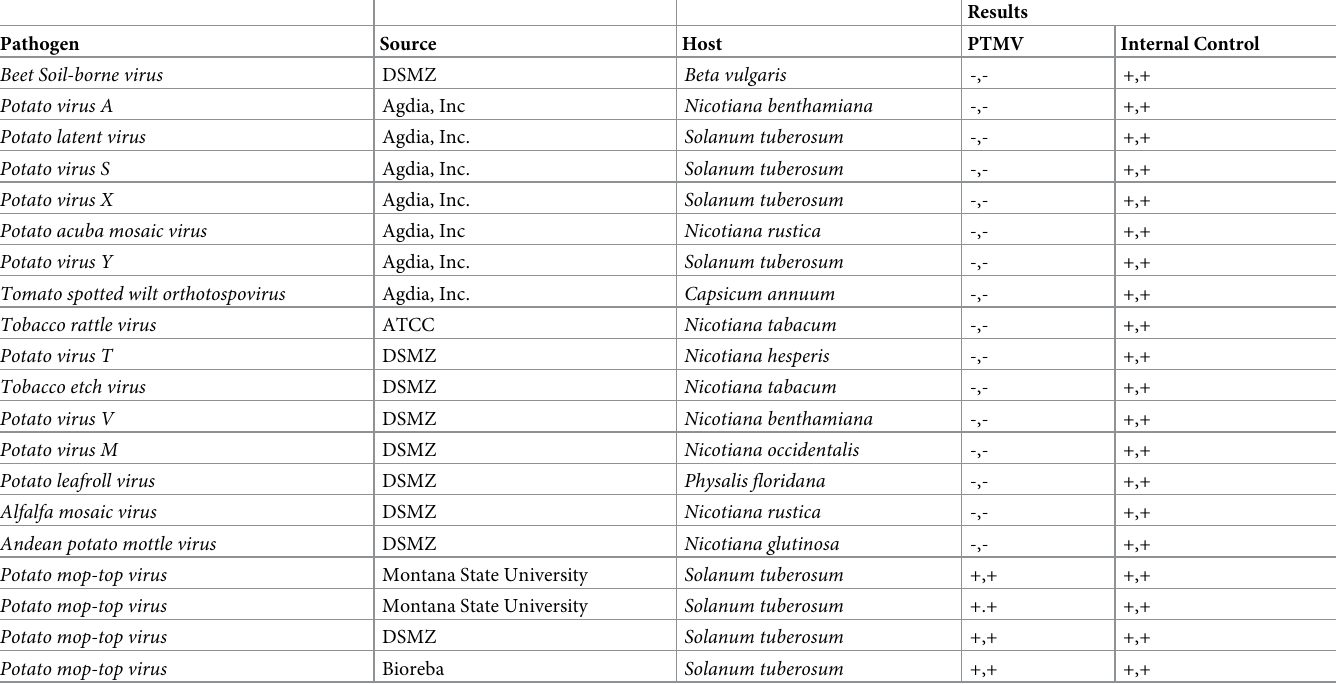
preparations of the RNA transcript defining the limit of detection (LOQ). The LOQ of our RPA assay was comparable to that of RT-qPCR and lower than that of the conventional RT-PCR by ten folds. Table 3. List of viruses tested to determine the specificity of the RPA assay. The multiplexed internal control amplifies the 18s rNRA of host plants and ensures the suit- ability of the potato mop-top virus (PMTV) results from a variety of host tissues, indicating successful reactions and true negative PMTV results.